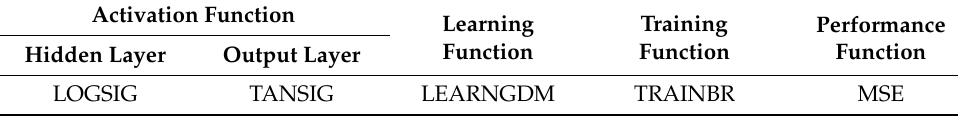
Figure 4. Influence of function combinations on training results. Table 3. Selection of BR-BPNN functions.